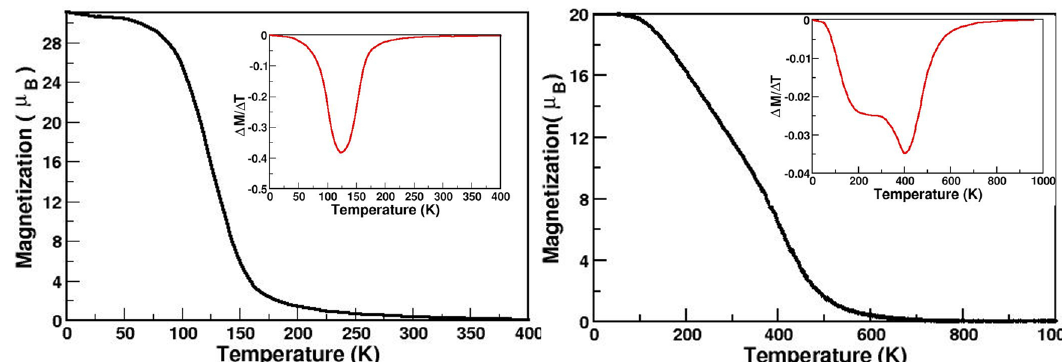
Figure 6. Magnetic properties of CaMn 1.25 Ni 0.75 ReO 6 (left) and CaMn 0.75 Co 1.25 ReO 6 (right) obtained from Monte-Carlo simulation. Insets show the derivative of magnetization as a function of